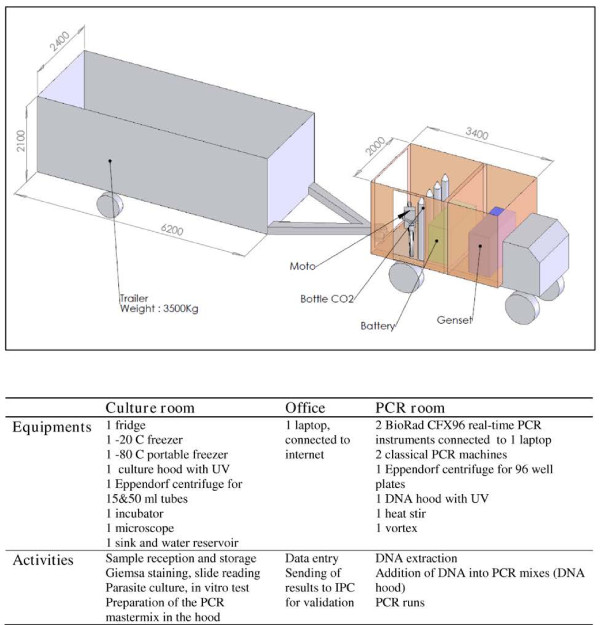
Design of the mobile laboratory.